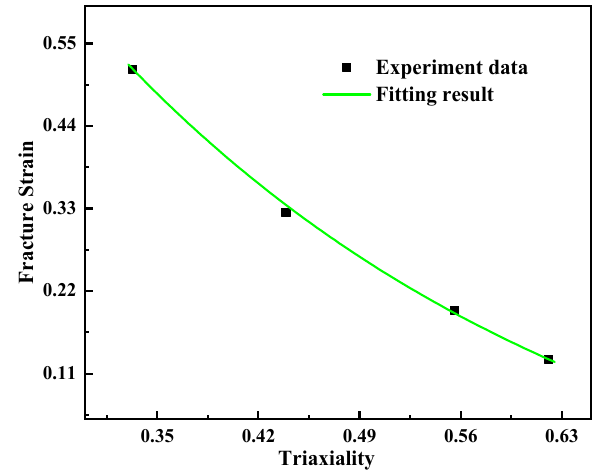
Figure 10. Relationship between stress triaxiality and fracture strain.